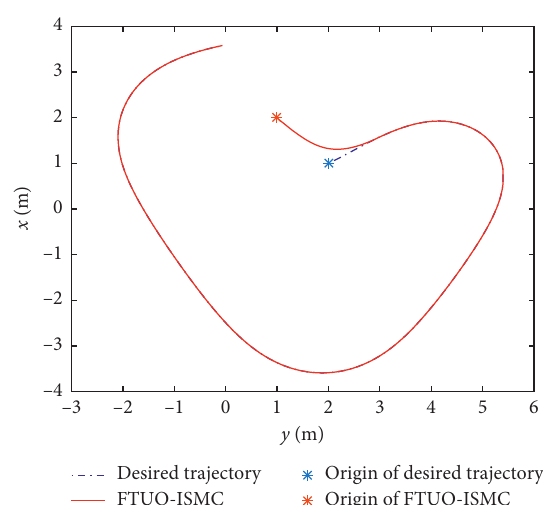
Figure 10: Position tracking errors on ISMC and FTDO-ISMC.